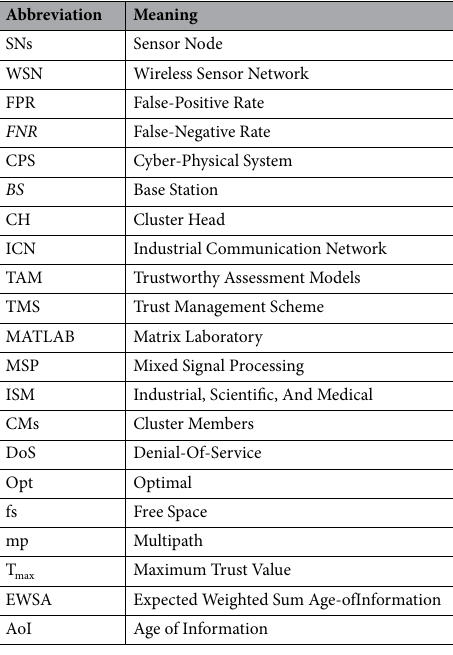
Table 3. List of abbreviations.